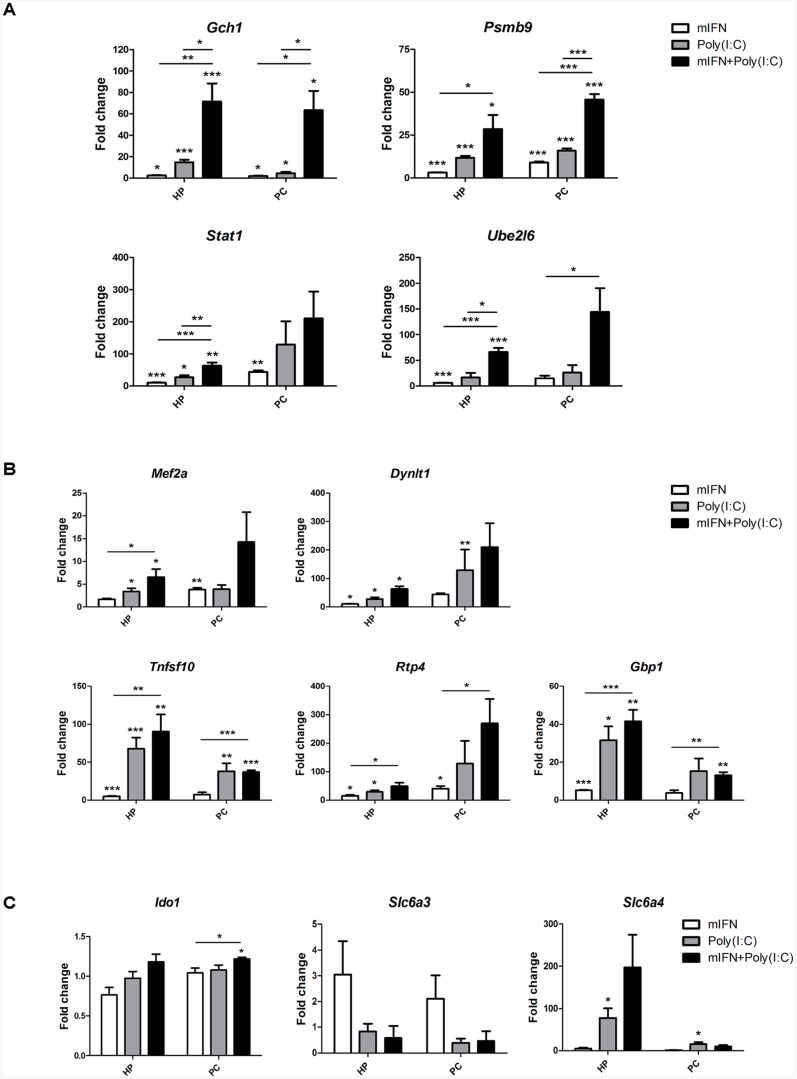
Expression of enhanced DRIIs and the most relevant genes of the 5-HT pathway in cultured neurons.Total RNA was isolated of 9–10 div. cultures hippocampal (HP) and prefrontal (PC) cortical neurons after stimulation during 24 h with mIFN (1000 IU/mL), poly(I:C) (100 µg/mL) and both, and induced expression was assessed by quantitative RT-PCR. (A) Genes with differential and significant upregulation after costimulation treatment in one or both studied cell types. (B) Other DRIIs showing a response to the treatments. (C) Genes related to 5-HT metabolism. DRIIs not responsive are shown in figure S1. The data are presented as mean values (± SEM). Asterisks indicate significant results (* p<0.05; ** p<0.01; *** p<0.001) using the Student's t-test.